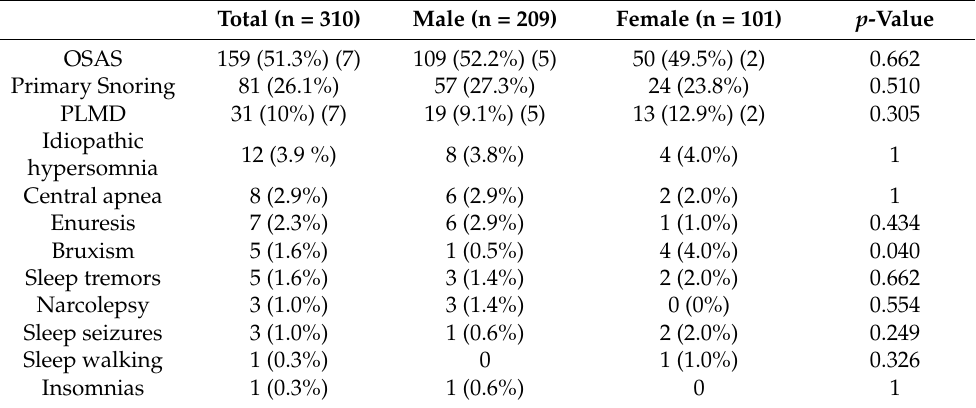
Table 1. Final diagnoses of the patients and comparison between male and female patients. The values presented as n